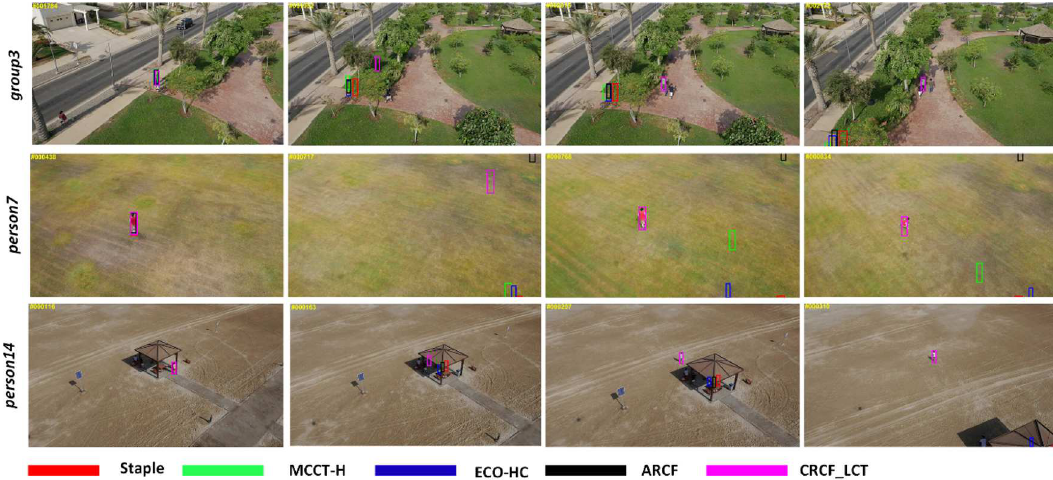
Figure 13. Tracking result visualization of our proposed CRCF_LCT tracker and comparative trackers on sequences group3, person7,